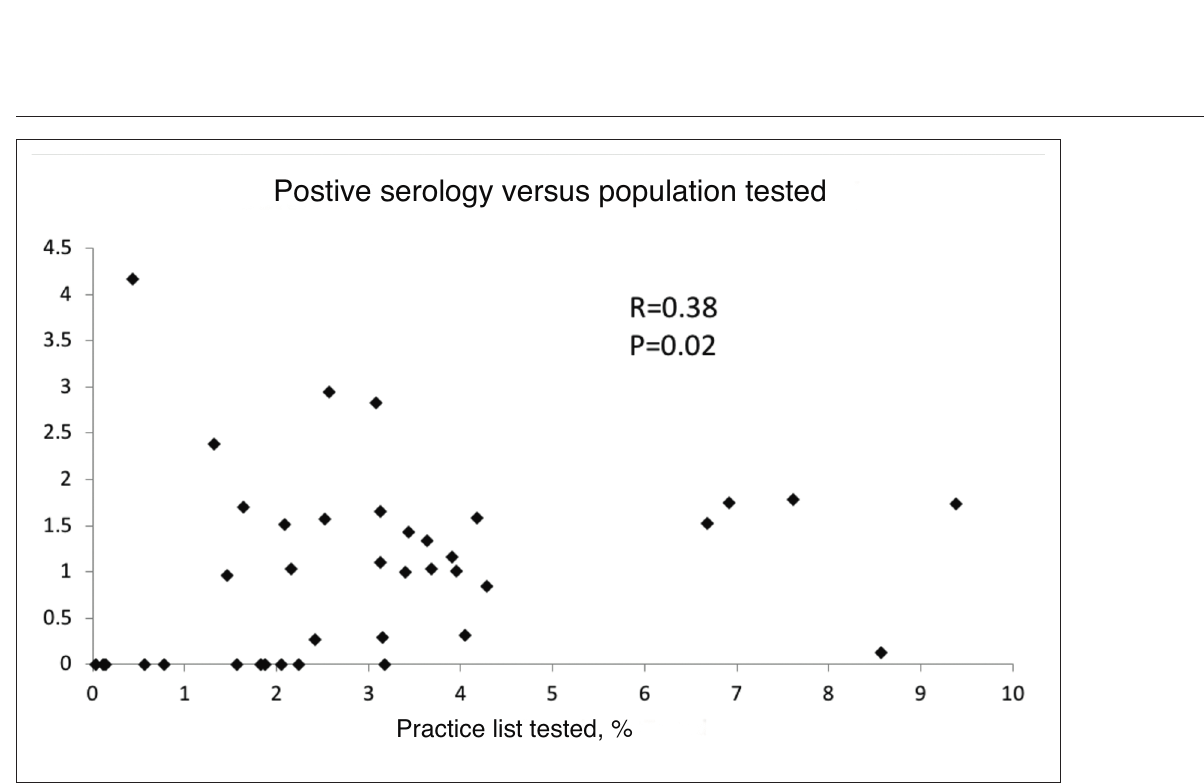
Figure 2 . Correlation between percentage of practice population tested and percentage of requests returning positive